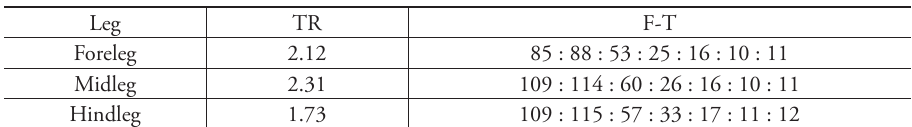
(Fig. 2f) are given as Table 1, metatibial distal bristles (Fig. 2g–h) with 5 or 6 spines, 1 st spine is longest. Table 1. Tarsal ratios (TR) and measurements of leg segments and tarsomeres from femur to tarsomere 5 (F-T) of all legs of C. fenggangensis sp. n. ( ♀ ). Leg TR F-T Foreleg 2.12 2.31 Hindleg 109 : 115 : 57 : 33 : 17 : 11 :